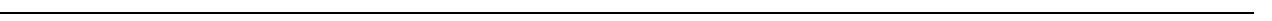
Fig. 2 Uhrf1 de fi ciency induces neural differentiation defects. a In vitro EB formation of WT, Uhrf1 KO, and Uhrf1 KO ESCs expressed with Uhrf1. ESCs were differentiated for 3 weeks as EBs. Arrows indicate the cystic hollow. The scale bar represents 4 mm. b Appearance of spontaneous contractile activity during EBs growth. EBs were examined daily under the microscope for the presence of a rhythmic beating until day 21. Data are from n = 3 independent experiments. c qPCR analysis of lineage- speci fi c markers and pluripotency marker upon in vitro differentiation. Data are expressed relative to WT ESCs values and values are normalized to β -actin. Data are from n = 3 independent experiments. The data values are mean ± s.d. ** P < 0.05 by unpaired, two- tailed Student ’ s t -test analysis. d Immunostaining of differentiated EBs. EBs were treated with Trypsin – EDTA at EB week 1 and plated onto gelatin-coated plates. Immunostaining with lineage-speci fi c markers was performed 2 days after plating. The scale bar represents 4 mm. e Teratomas derived from immune de fi ciency mice. Scale bar represent 1 cm. f Representative histological sections from teratomas that developed in immunode fi cient mice following injection with WT and Uhrf1 KO ESCs. Haematoxylin and eosin (H&E) staining reveal characteristic tissues from the endoderm, mesoderm, and ectoderm. The data are represented as n = 6 experimental replicates. The Scale bar represents 4 mm. g Expression pattern of transcriptional modules related to muscle differentiation and neuronal differentiation. Thick red and blue lines represent average relative gene expression to WT at week 0 in WT and Uhrf1 KO, respectively. Ribbon colors represent SEM. Representative genes and overrepresented GO terms are shown. Asterisk (*) represents signi fi cant difference (>1.25 fold change and Student ’ s t -test p -value < 0.05) of gene expression between WT and Uhrf1 KO in each module. h Disruption of bivalent and repressive promoters in developmental genes. Over representation of GO terms in genes with changes from bivalent to active (B – A) and to repressive (B – R) and from repressive to no mark (R – N) is shown by heat